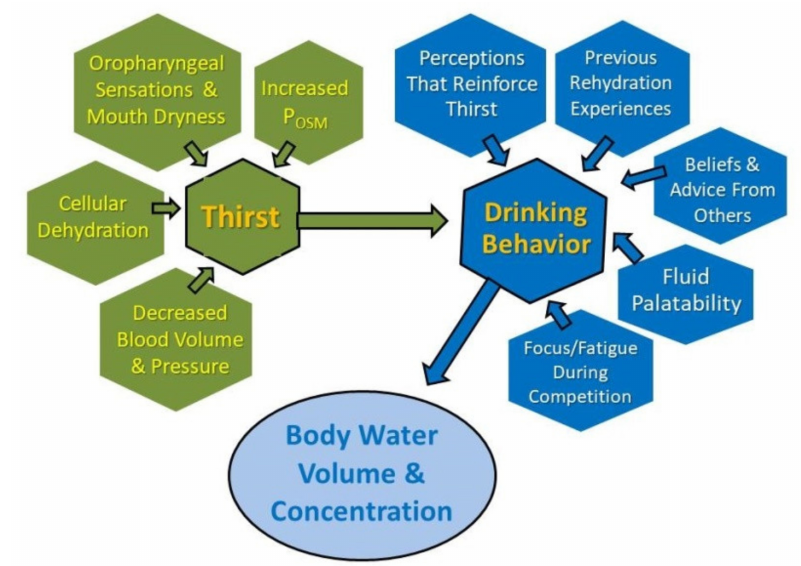
Figure 4. Influences on thirst and drinking behavior during endurance exercise. All factors in this diagram are perceived, monitored, and/or regulated by the brain.